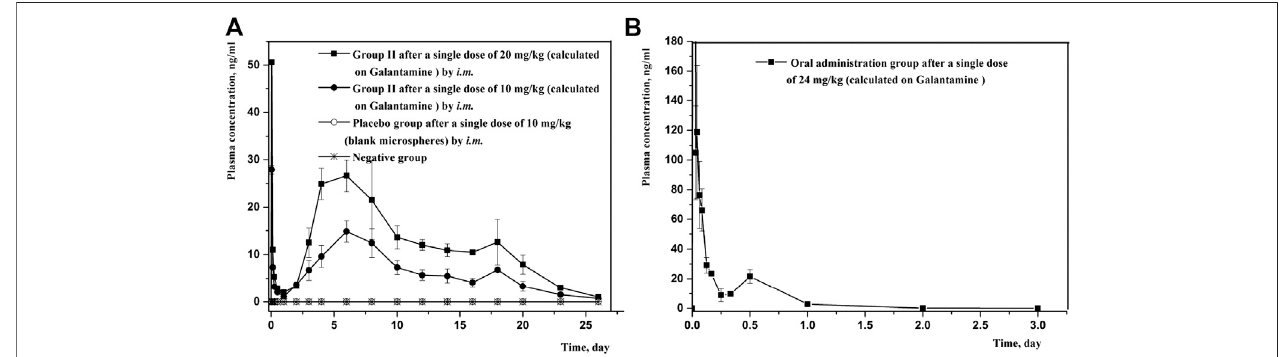
FIGURE 8 | Mean plasma concentration-time pro fi les of rats following intramuscular injection and oral administration of GLT-PM-MS. (mean ± SD, n (cid:2) 6).